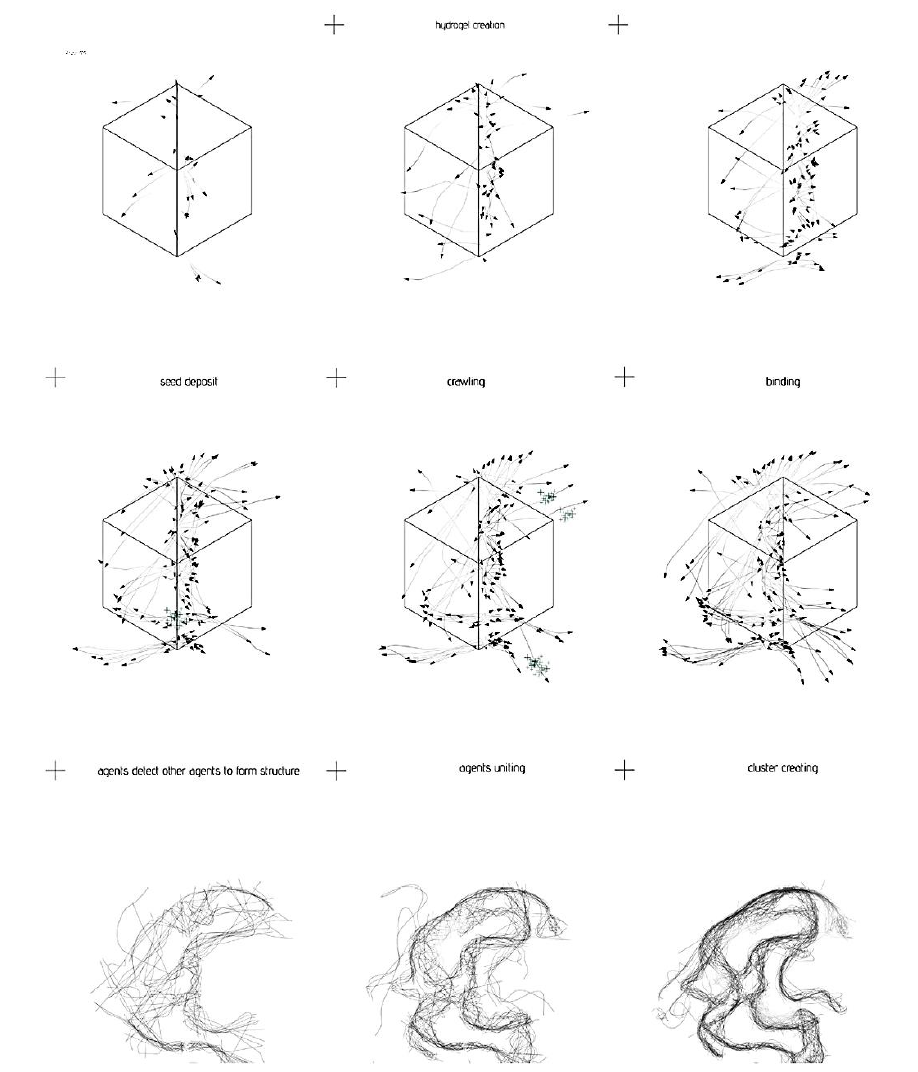
Figure 2. Structural stabilization of the spatial